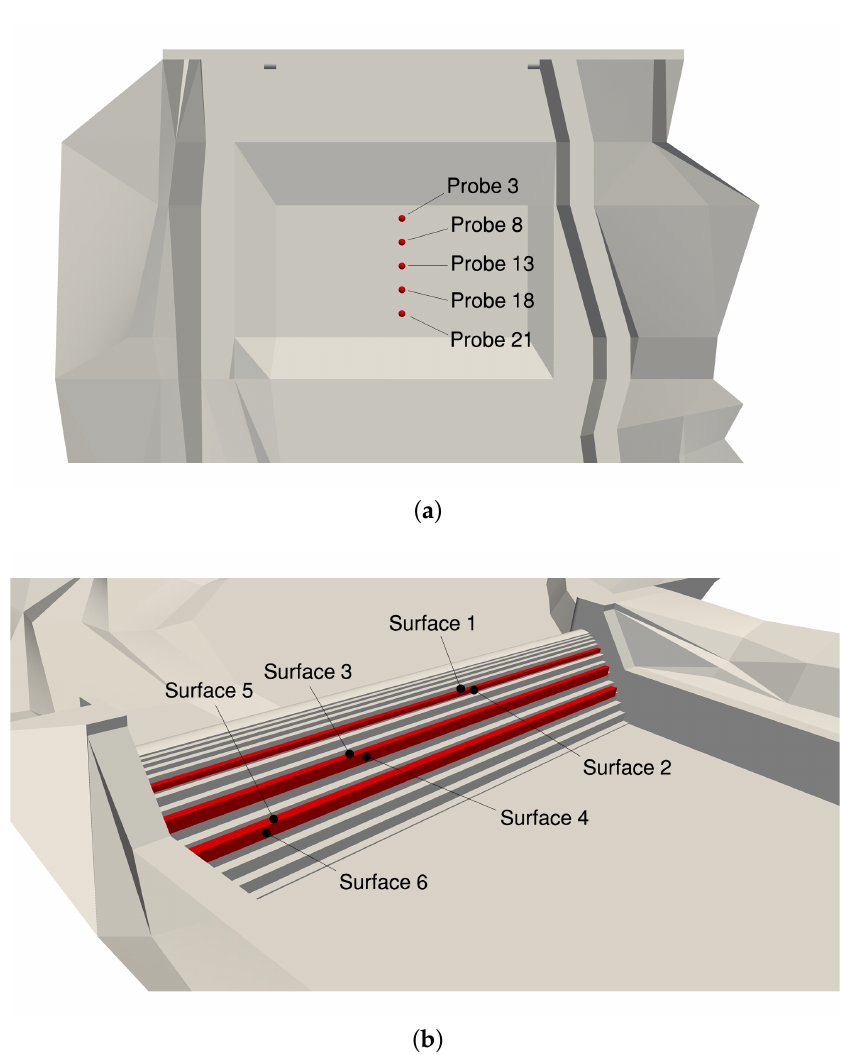
Figure 7. Locations (shown in red) for pressure measurements comparison with the experiments: ( a ) pressure probes at the bottom of the dissipation basin, ( b ) surfaces for average pressure calculation along the stair-step profile of the secondary dam (1, 3 and 5, horizontal surfaces; 2, 4 and 6, vertical surfaces). Note the labels of the pressure probes in the dissipation tank follows from that of the physical